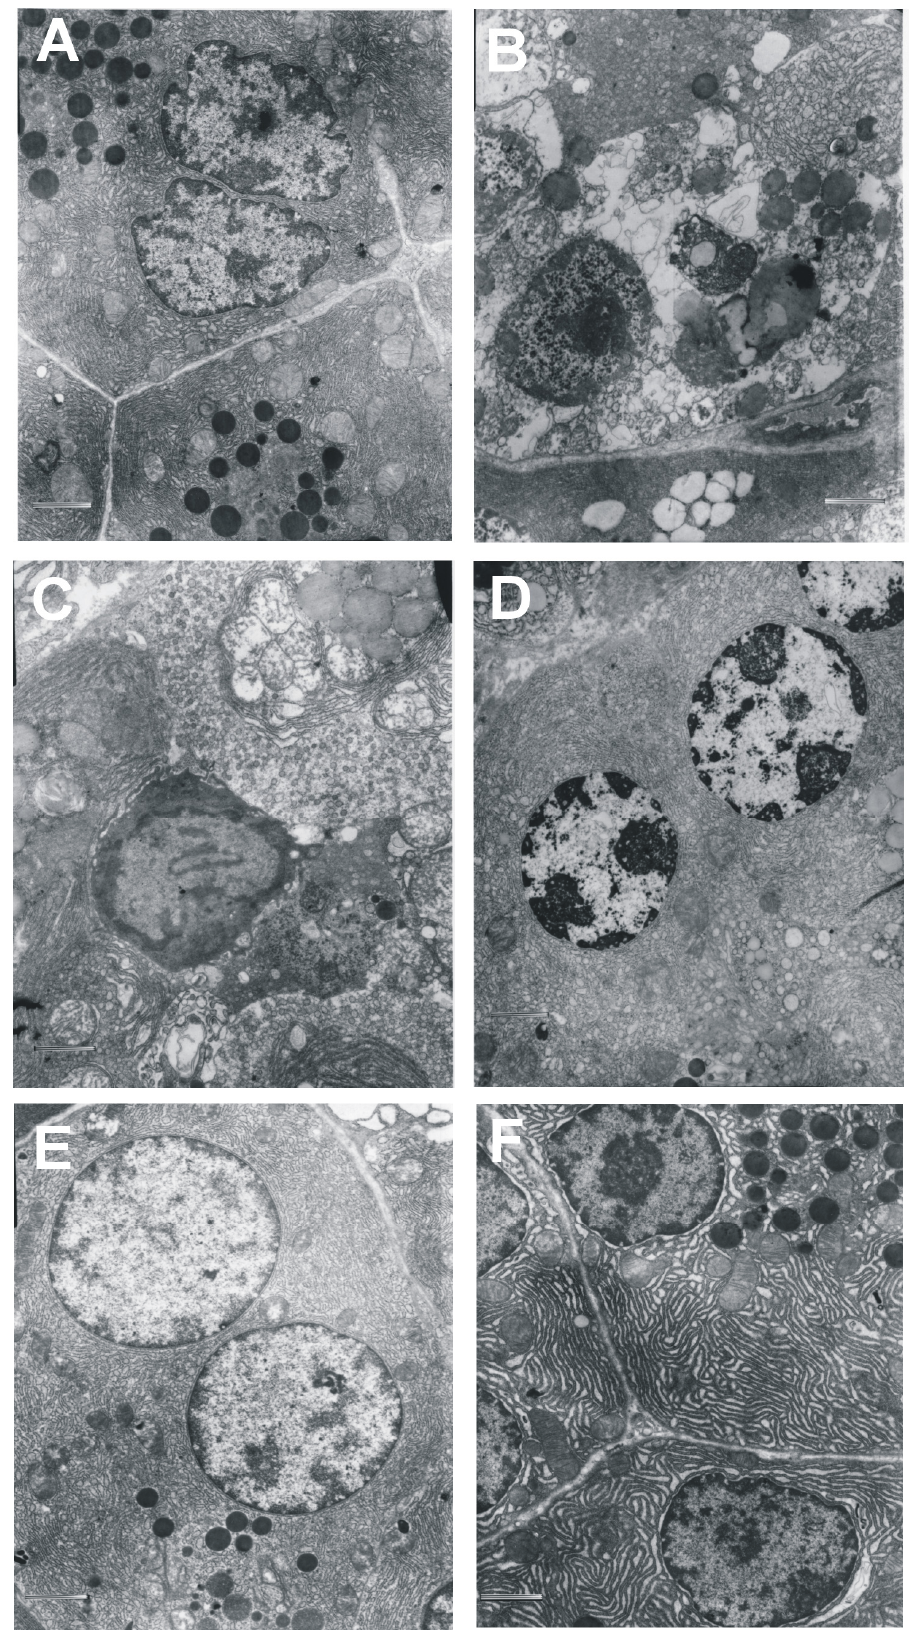
Figure 2. Morphological changes of the pancreatic acinar cells upon L -arginine induced necrosis and apoptosis. Protective effect of